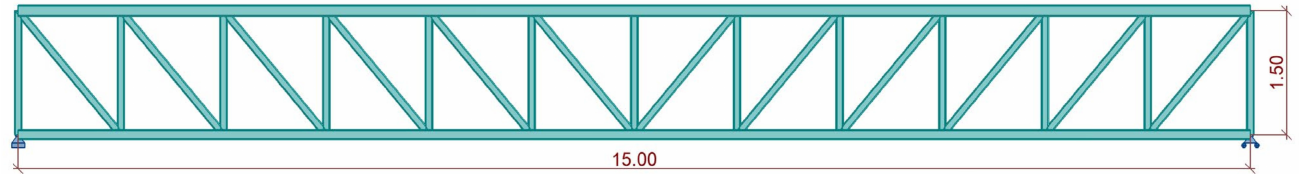
Figure 2. Static scheme of the given Pratt truss structure—Autodesk ROBOT